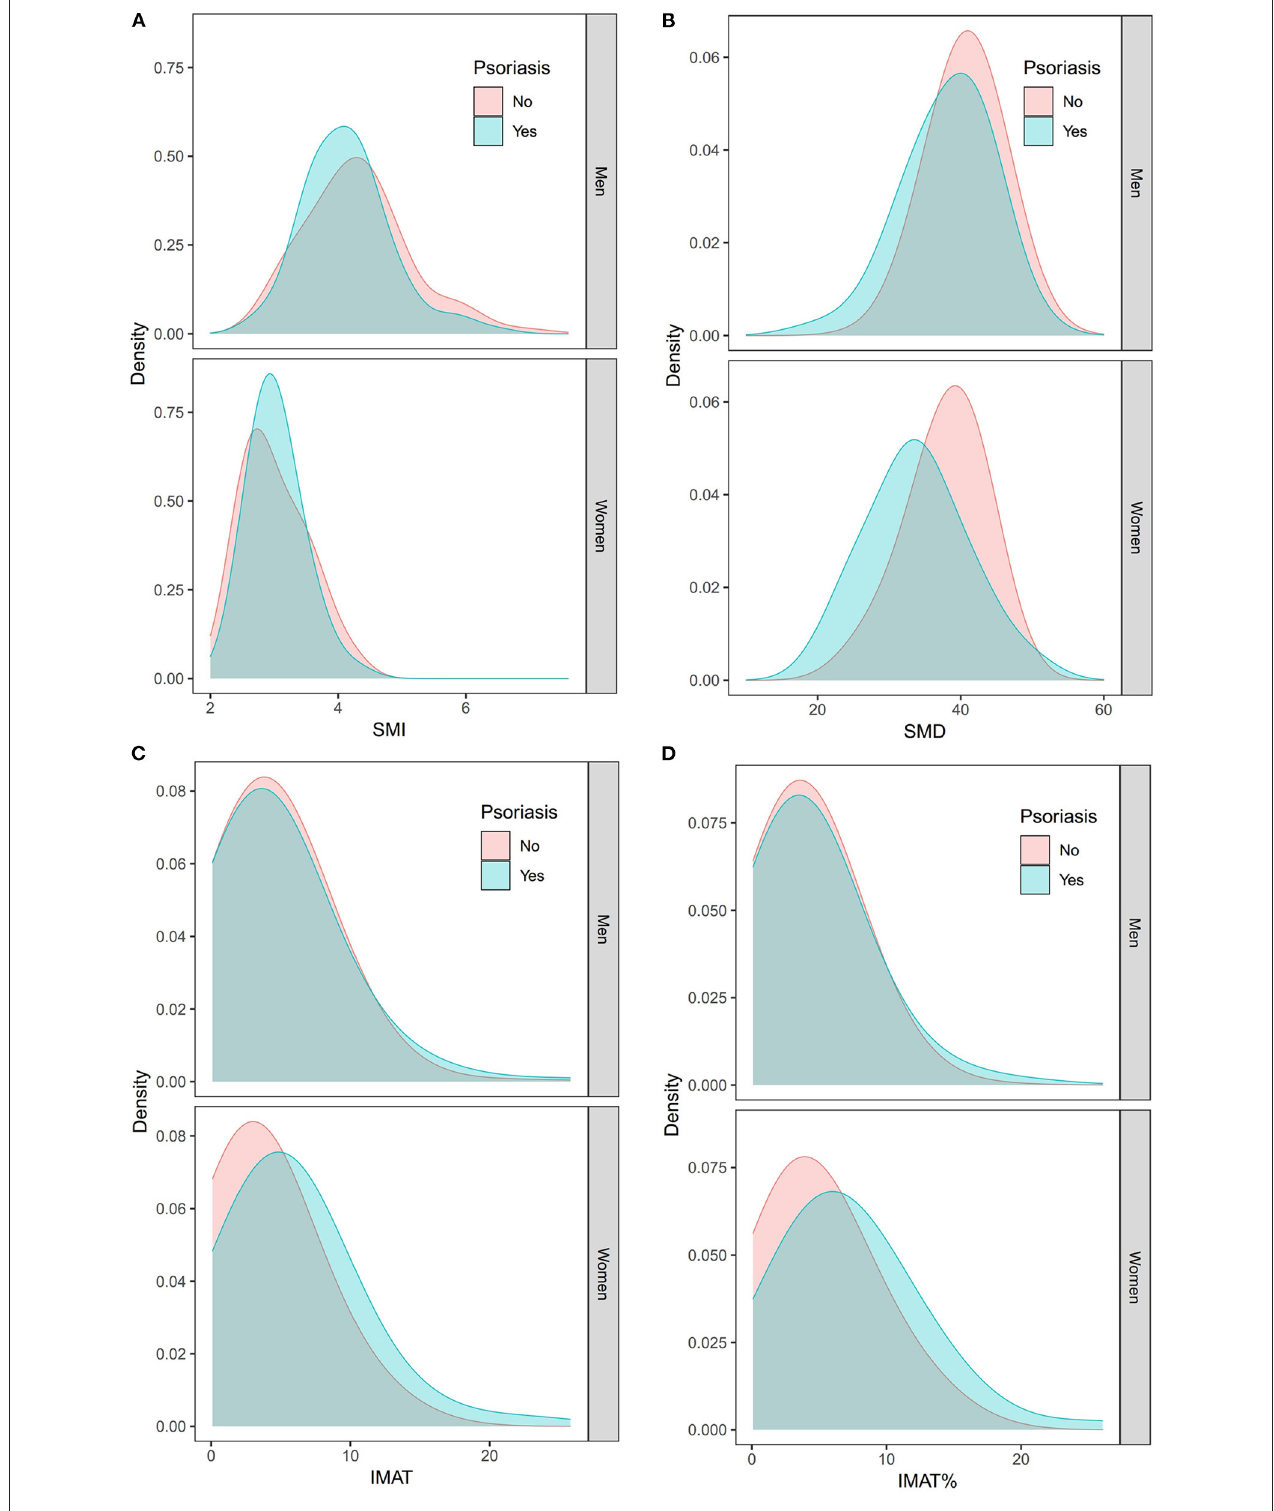
FIGURE 3 | Density distributions of the SMI (A) , SMD (B) , IMAT (C) , and IMAT% (D) in the psoriasis group and the control group stratified by sex. IMAT, intermuscular adiposity tissue; IMAT%, percentage of IMAT; SMD, skeletal muscle radiodensity; SMI, skeletal muscle index.